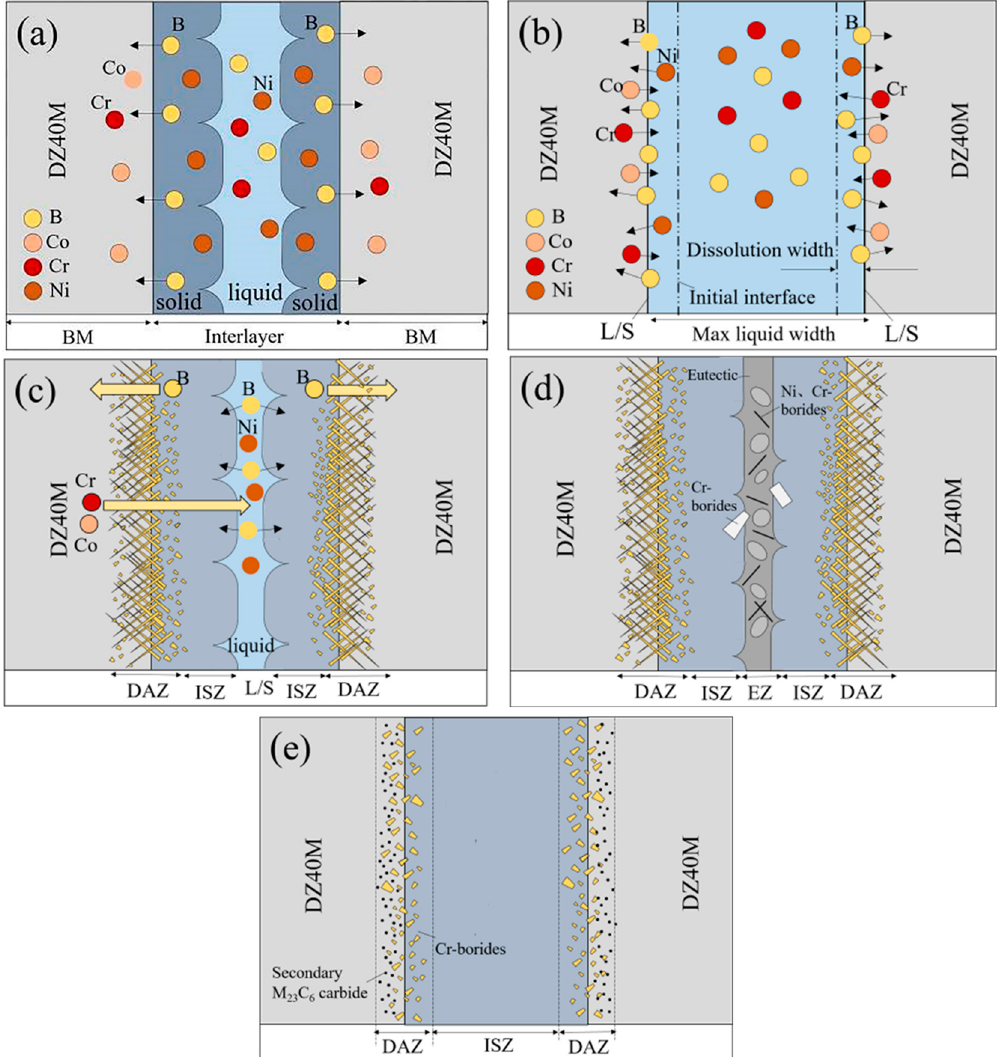
Figure 7. Schematic of the microstructure evolution mechanism of the brazed joint: ( a ) melting stage; ( b ) extension stage; ( c ) isothermal solidification stage; Typical microstructure of the brazed joint: ( d ) incomplete isothermal solidification; ( e ) complete isothermal solidification.